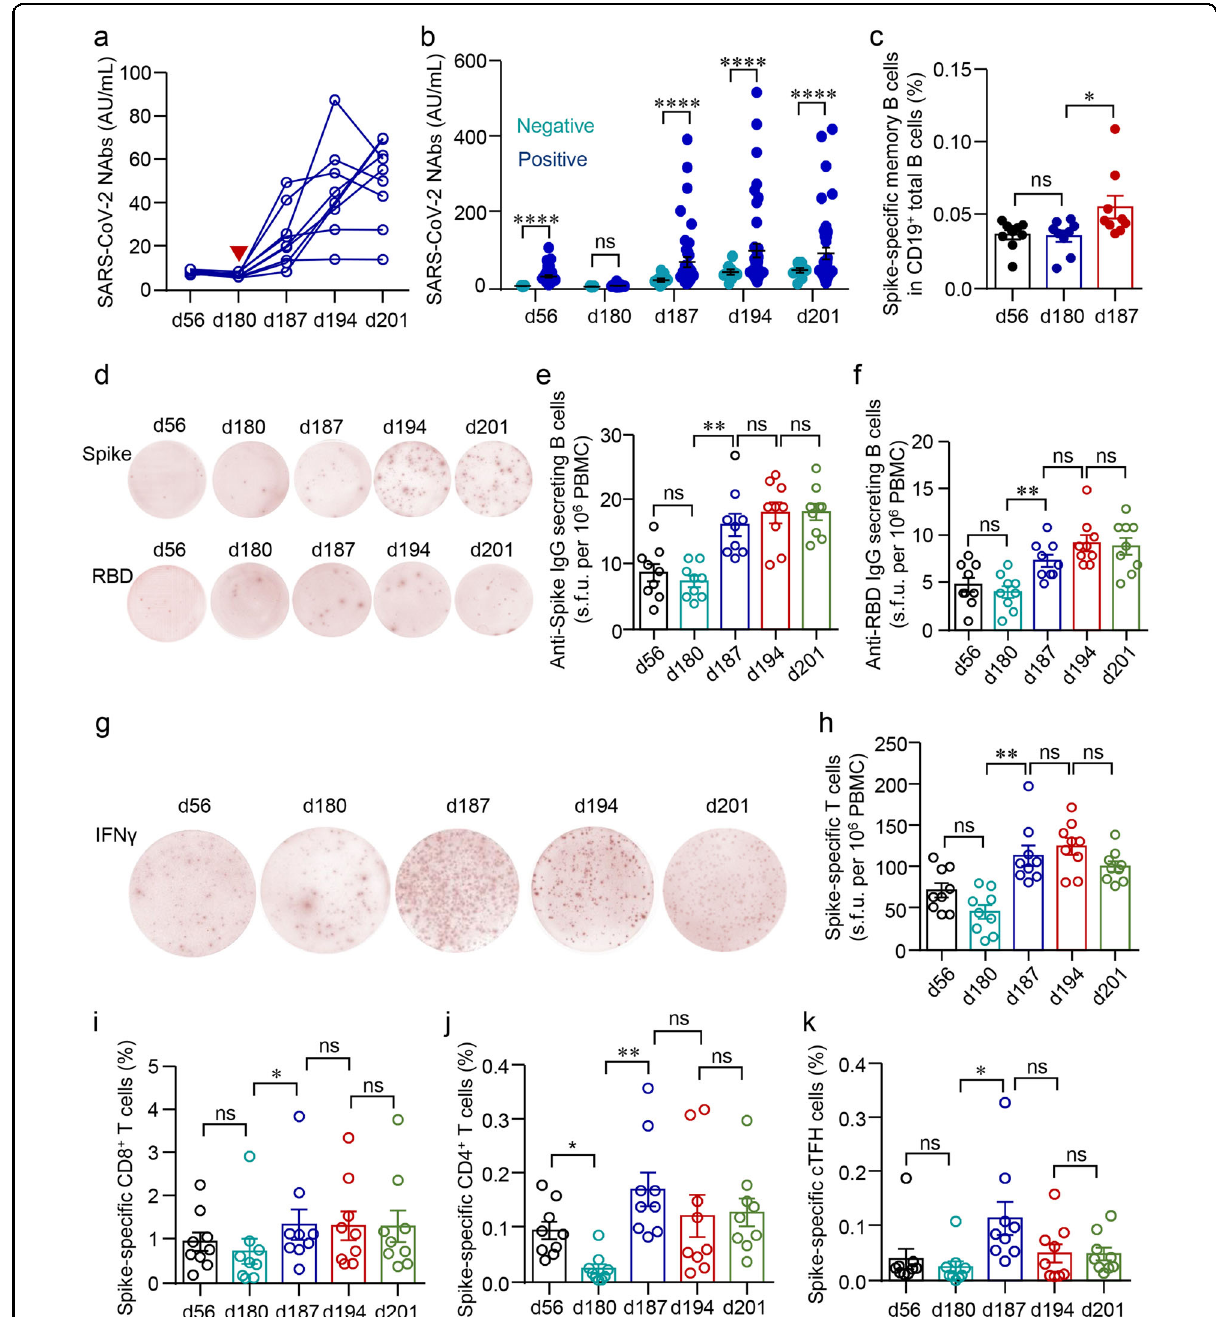
Fig. 5 Immune responses in HCWs with minimal serologic response to a standard two-dose vaccination schedule. a Serum NAbs in HCWs with minimal serologic response to a standard two-dose vaccination schedule were analyzed longitudinally at different time points before and after the third dose (red arrow). b Comparison of NAbs between vaccinees with negative or positive serological responses to a standard two-dose vaccination schedule. c Percentages of spike-speci fi c memory B cells in HCWs with a negative serological response to a standard two-dose vaccination schedule. d – f Numbers of spike- or RBD-speci fi c IgG-producing B cells in HCWs with a negative serological response to a standard two- dose vaccination schedule. g , h Numbers of spike-speci fi c IFN γ -producing T cells as detected by ELISpot in HCWs with a negative serological response to a standard two-dose vaccination schedule. i – k Spike-speci fi c T cells, including CD69 + 4-1BB + CD8 + T cells, OX40 + 4-1BB + CD4 + T cells, and CXCR5 + OX40 + 4-1BB + cTFH in HCWs with a negative serological response to a standard two-dose vaccination schedule. Comparisons were done by Wilcoxon rank-sum test in b and one-way ANOVA corrected for multiple comparisons in the rest panels. * P < 0.05, ** P < 0.01, **** P < 0.0001; ns, not signi fi